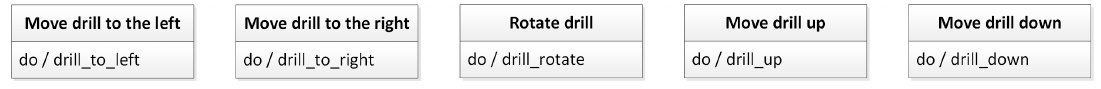
Figure 6. Several simple states within the “Normal mode.”